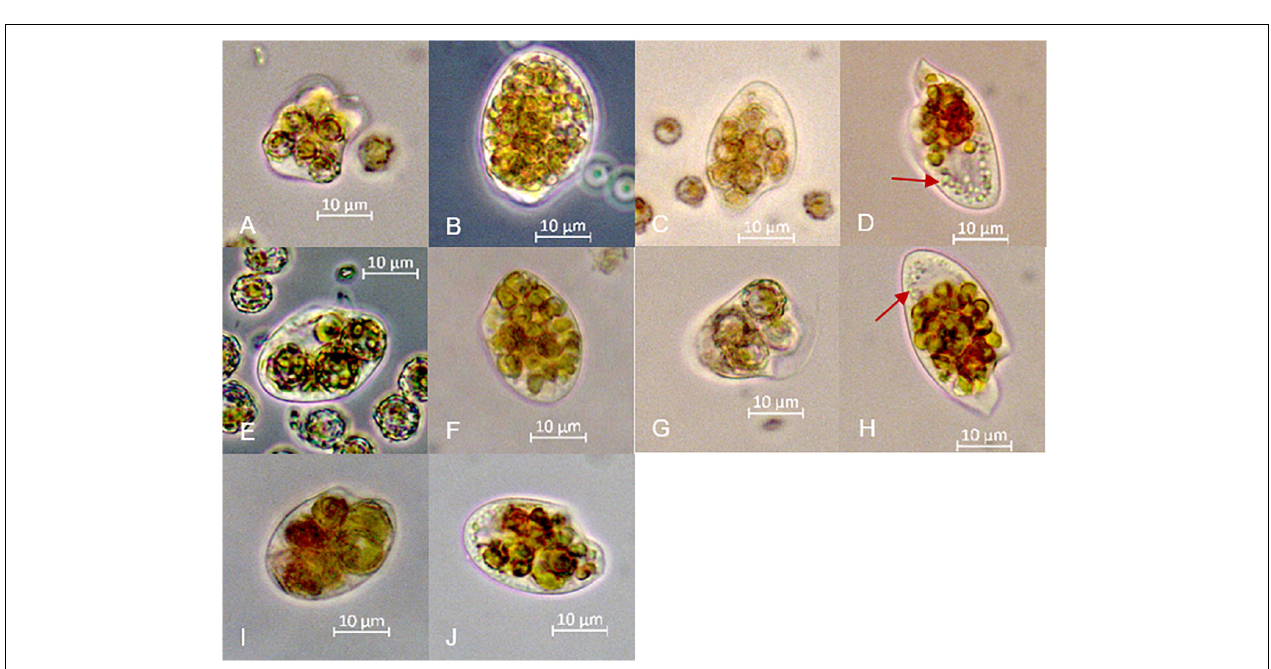
FIGURE 4 | Concentrations (mean ± SD) of calcified (blue) and decalcified (red) cells within the mixed treatment. (A) E. huxleyi without, and (B) with grazers. (C) P. carterae without and (D) with predators. (E) G. oceanica without and (F) in the presence of O. marina .